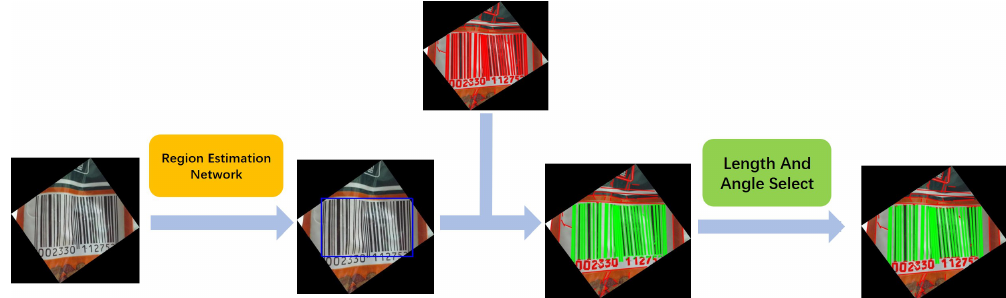
Figure 3. Line segment selection procedure: Given the rectangle region from the region estimation network, if the midpoint of the line segment is in this region, the line should be chosen as a barcode line segment. After removing the line segments with a short length and deviated angle, the selected line segments will generate a convex